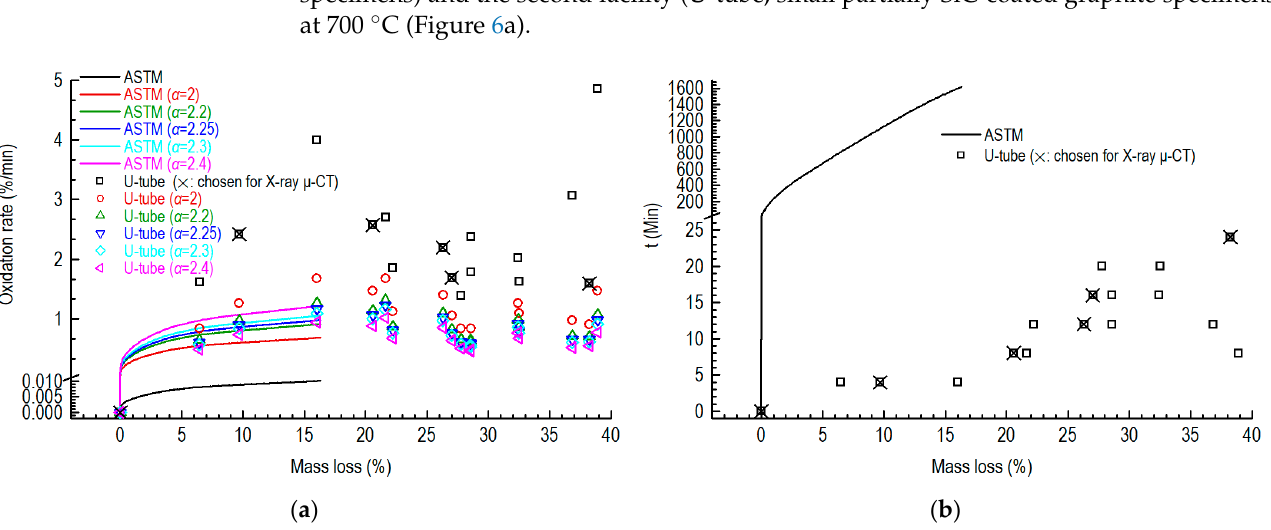
Figure 6. Oxidation rates and times versus mass losses of related specimens oxidized at 700 °C: ( a ) oxidation rates versus mass losses; ( b ) oxidation times versus mass losses ( 𝛼 : correction